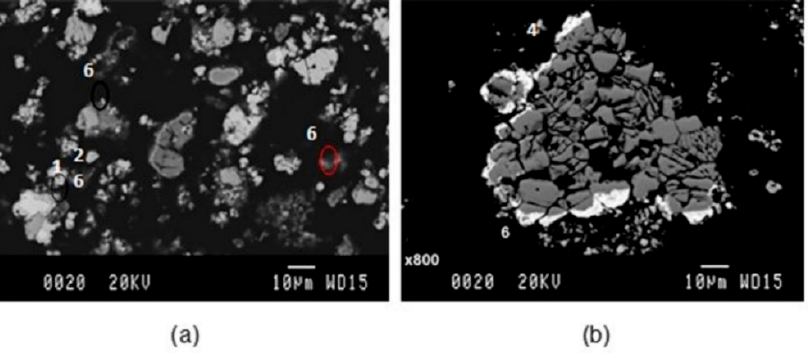
Figure 9. Pb-rich particles of BaSO 4 (phase 6), AgCl (phase 2), Ag-Cl-Se, and Sb-Pb-O (phase 4). Variable size between 2 µm ( a ) and 50 µm ( b ). Table 8. Semi-quantitative analysis of Ba-S-O.